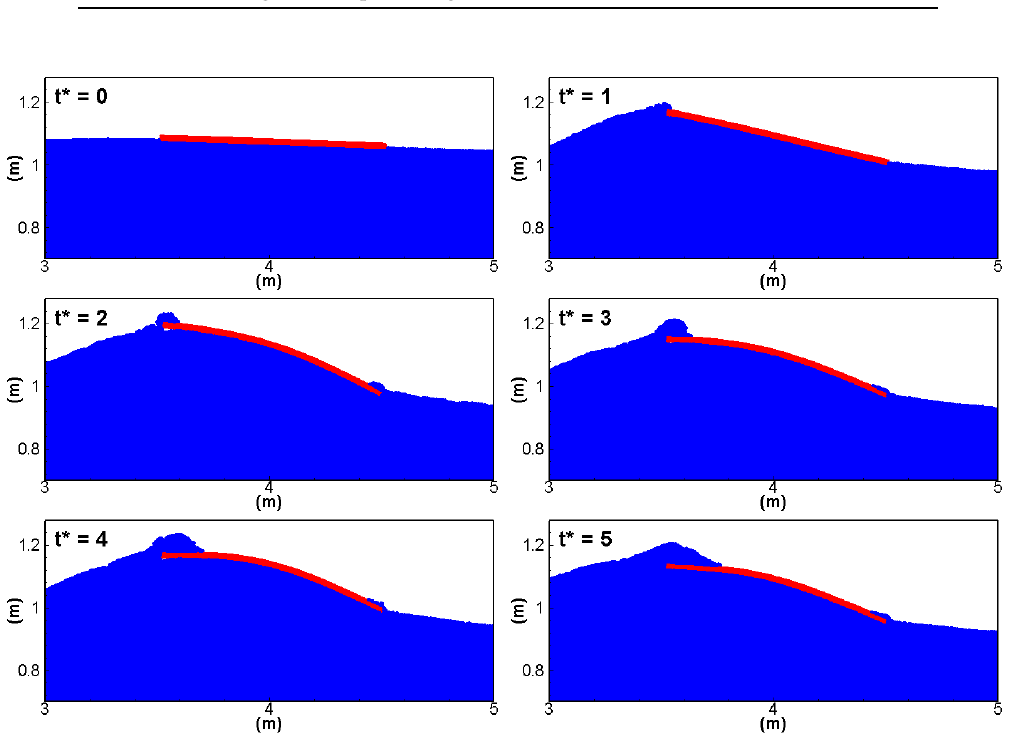
Figure 4. Dynamics of the floating plate with Young modulus E = 250 MPa under less severe wave conditions with wave steepness ka = 0.295. Ratio of the plate length to the wavelength is 2 L / λ =